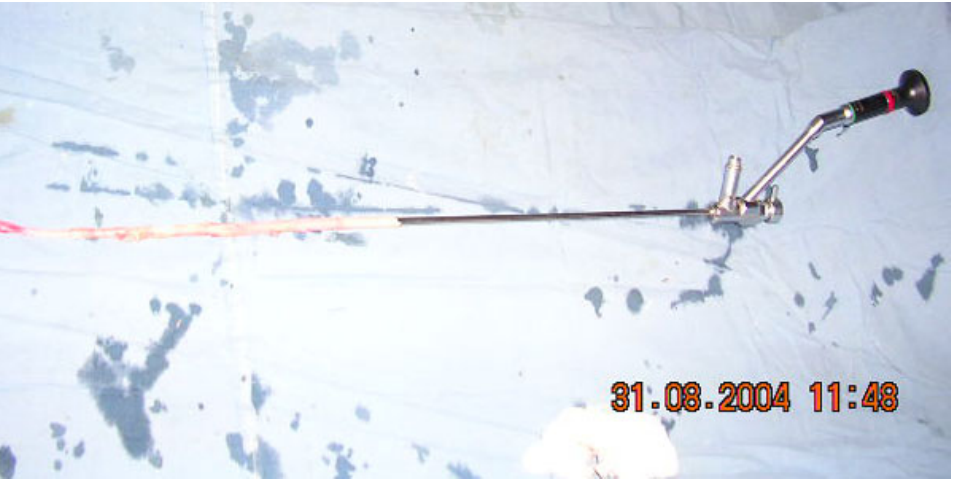
FIGURE 1 . Ureteric avulsion.